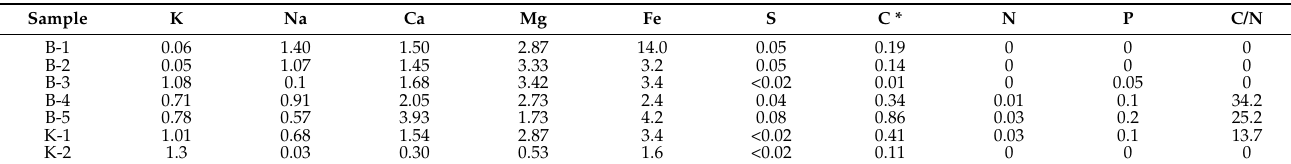
Table 2. Elements content in clay samples, mass